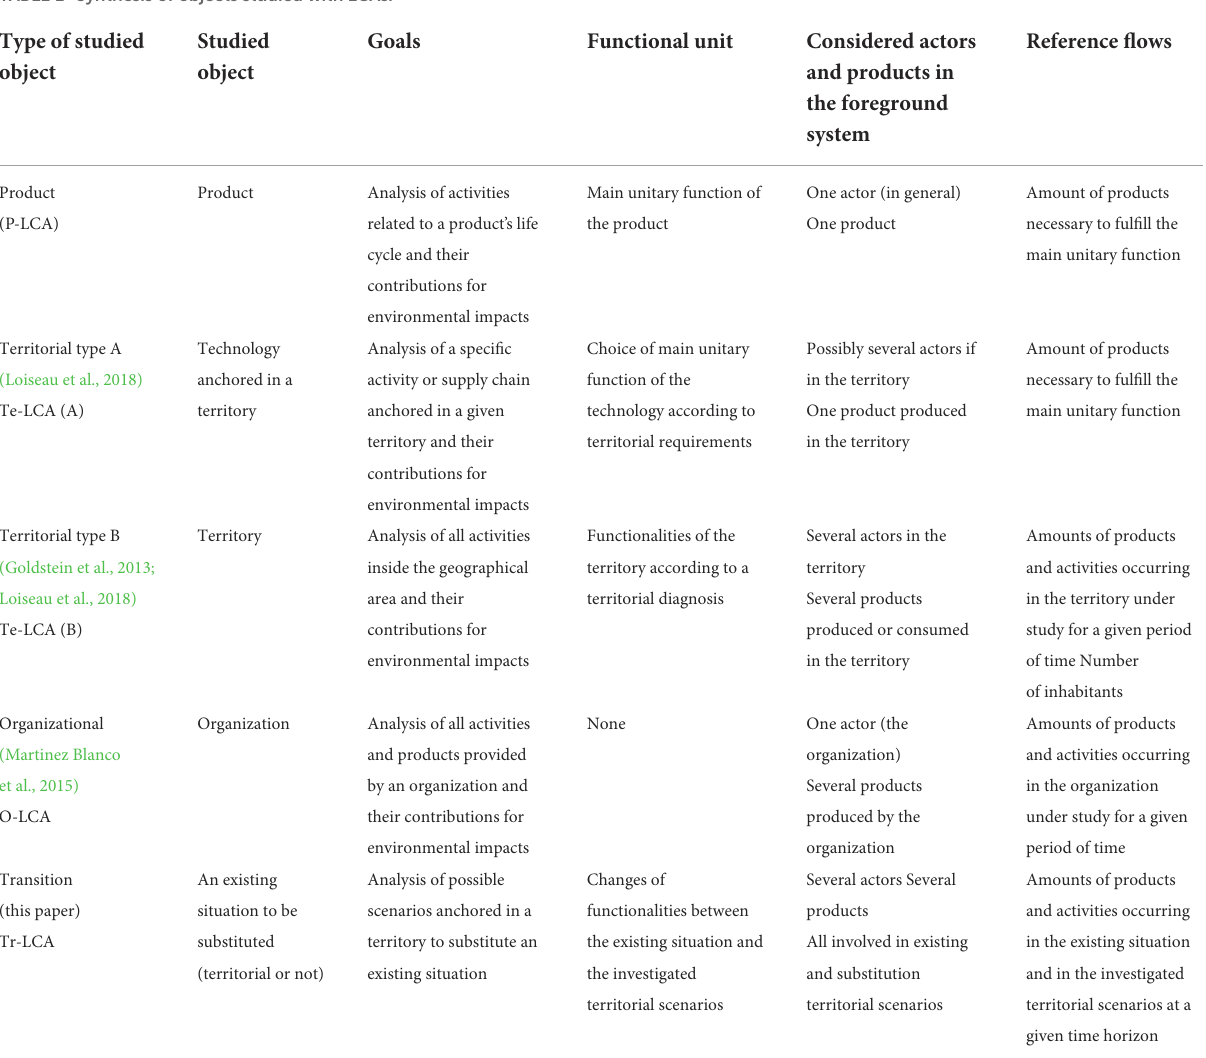
TABLE 1 Synthesis of objects studied with